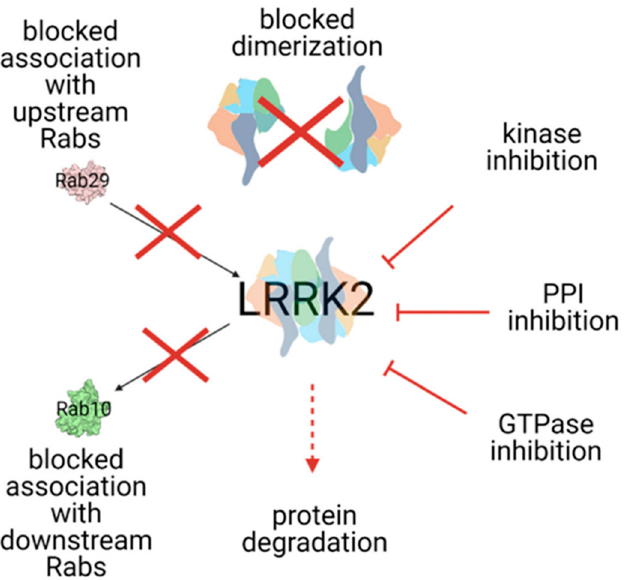
Figure 2. Summarized LRRK2 targeting strategies. LRRK2 dysfunction induces an increase in kinase activity, influencing PD development. Inhibition of LRRK2 kinase activity could prevente or restore several impaired cellular processes (see the text for details). Cross: blocked pathwas; full arrow: promoting activities; dashed arrow: final effect of the strategies. From [145].